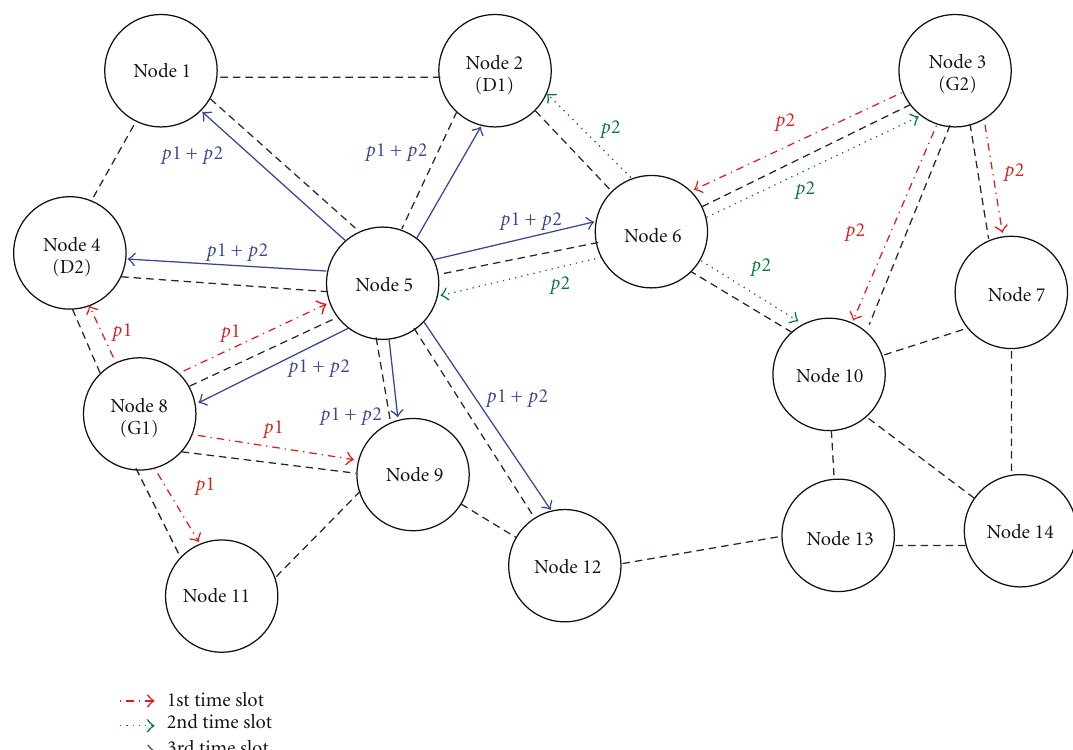
Figure 1: Mobile wireless multihop network. Two di ff erent information flows exist between two generator-destination pairs G1–D1 and G2–D2. Thin dashed lines represent wireless connectivity among nodes while thick lines represent packet transmissions. In the first time slot generator G1 and G2 broadcast their packets p 1 and p 2, respectively, (thick dash-dotted line). In the second time slot, node 6 broadcasts packet p 2 (thick dotted line) received in previous slot. In the third time slot, node 5 broadcasts the linear combination of packets p 1 and p 2 ( p 1 + p 2). Destination nodes D1 and D2 can, respectively, obtain packets p 1 and p 2 from p 1 + p 2 using their knowledge about packets p 2 and p 1 overheard during previous